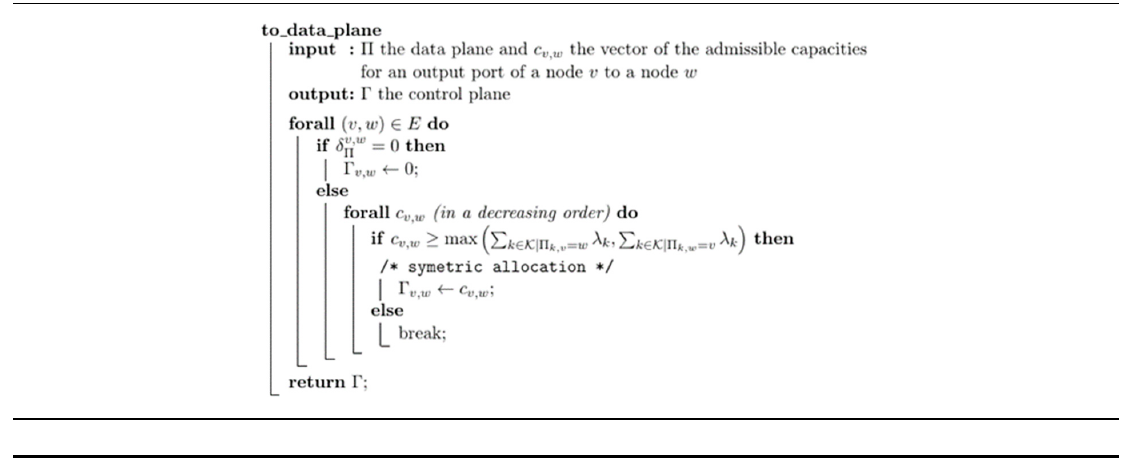
Algorithm 1. Retrieval of data and control plane from chromosome. Algorithm 2. Computation of the minimum control plane from given data plane.